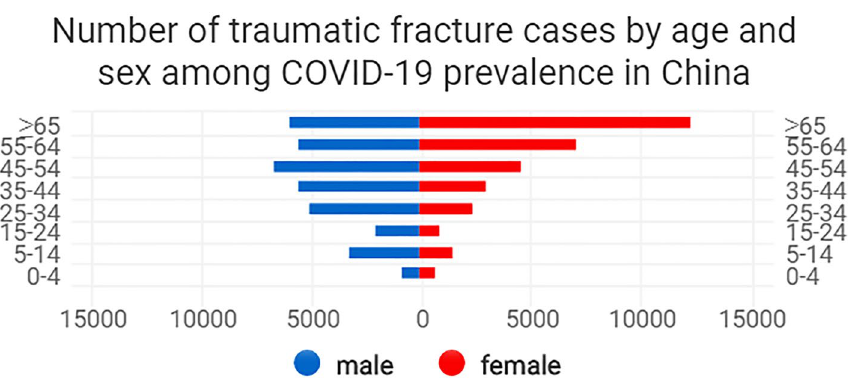
Figure 3. Number of traumatic fracture cases by age and sex that occurred during the period of COVID-19 prevalence in